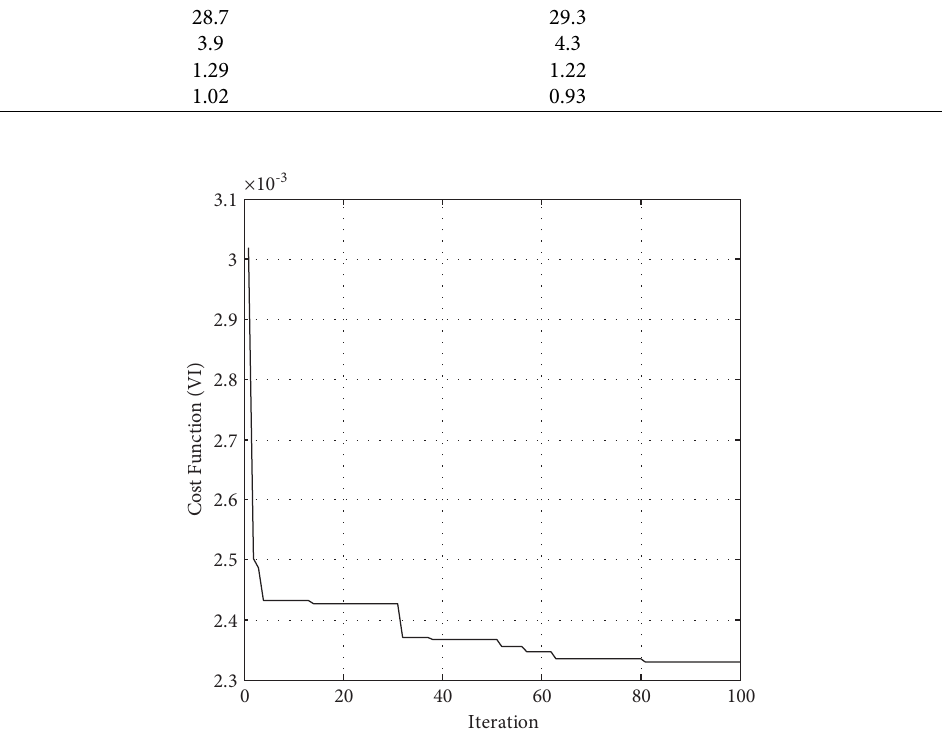
Figure 8: The cost function values in each step.